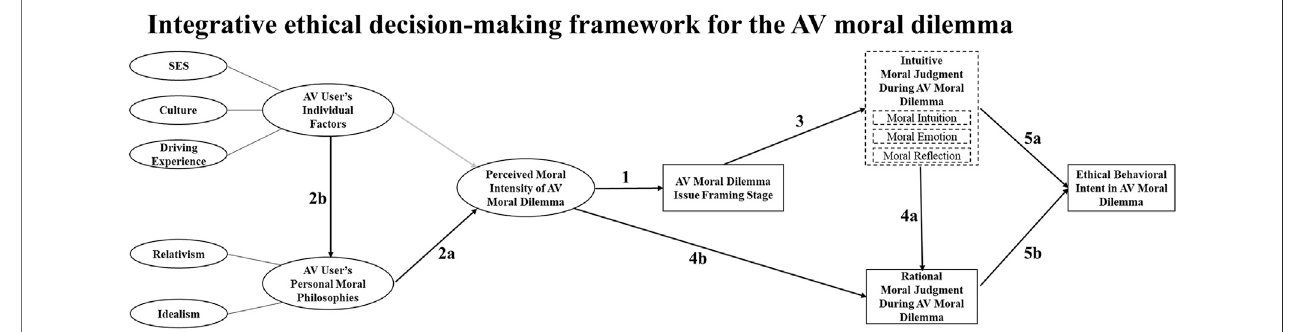
FIGURE 3 | Integrative ethical decision-making framework for the AV moral